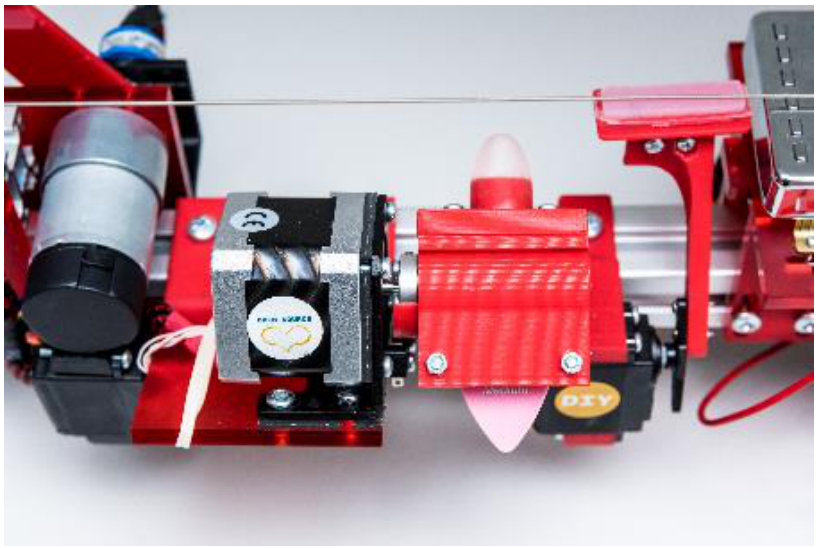
Fig. 4. Group I picker and damper. Note the silicone